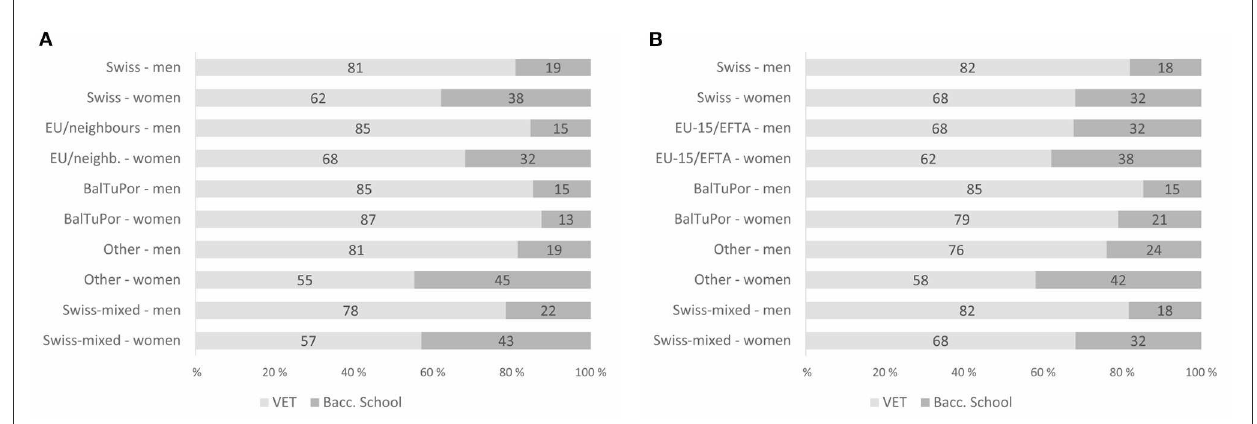
FIGURE1 Upper secondary track attended, by migration background and gender. Remarks: Samples based on observations reported in Table 1. Estimates based on 25 imputed data sets using survey weights. Data: TREE/DAB; own calculations. (A) TREE sample. (B) DAB